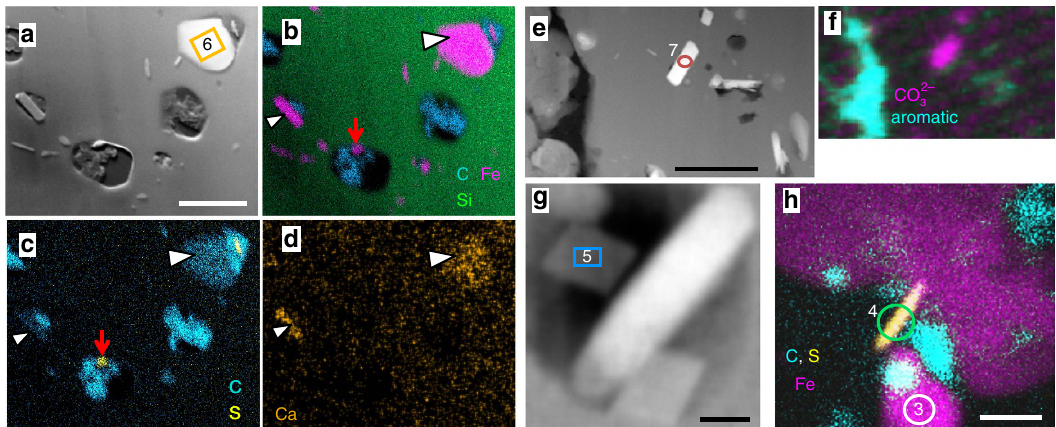
Figure 4 | Intra-microfossil siderite and Fe 2 þ sulfides. ( a ) STEM dark-field image. ( b – d ) EDXS mappings of a showing quartz (Si: green in b ), siderite (Fe: pink in b , minor Ca: orange in d , arrowheads), and Fe þ S minerals (S in yellow in c , red arrows in b , c ) that are systematically nanoscale and embedded in organic matter (C: cyan in b , c ). Scale bar, 500nm. ( e , f ) STEM dark-field image ( e ) and STXM mapping ( f ) of e showing carbonate (pink) and aromatic carbon (cyan). The rod-shaped (red circle) crystal is siderite. Scale bar, 500nm. ( g ) STEM dark-field image showing rhombohedra of siderite (for example, blue box) associated with greenalite (white rod). Scale bar, 50nm. ( h ) EDXS mapping of a nanoscale Fe 2 þ and S (yellow) crystal embedded in organic carbon (cyan) between two greenalite (Fe: pink) crystals. Scale bar, 100nm. Numbered boxes and circles in a , e , g , h outline target areas of EDXS spectra displayed in Supplementary Figs 15 and 16 with corresponding